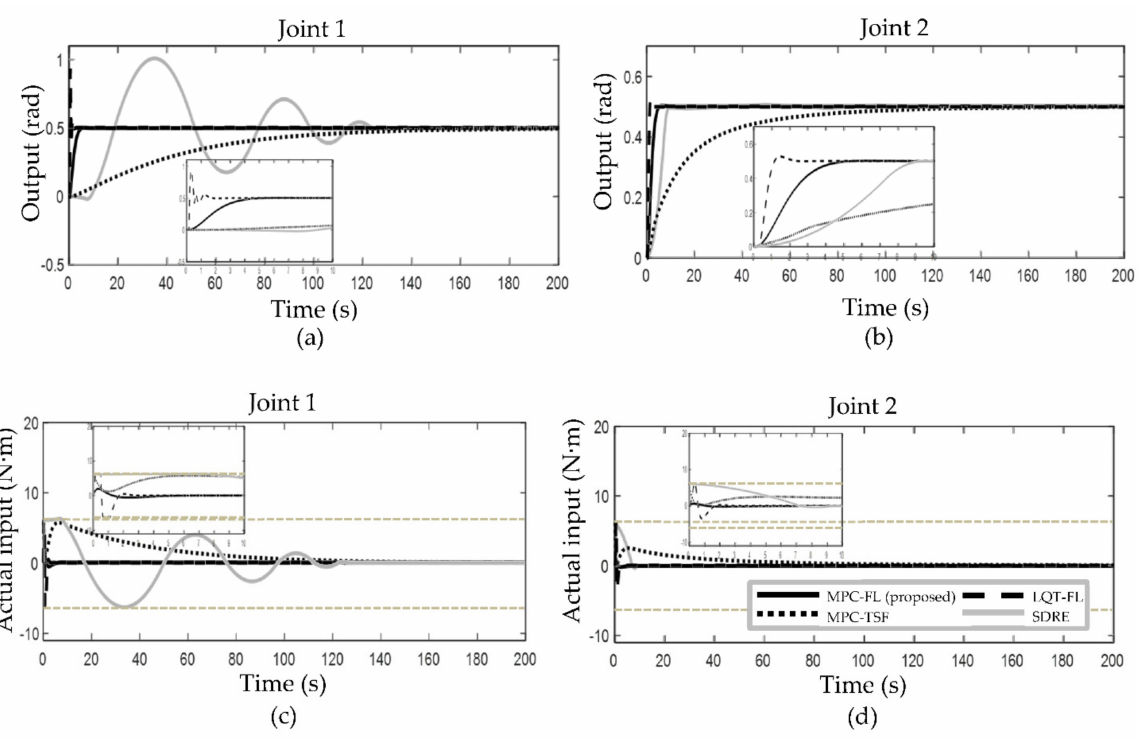
Figure 11. Two-link robot arm by applying the four control schemes with input constraints ± 6.1 N · m: ( a ) output responses of joint 1; ( b ) output responses of joint 2; ( c ) input signals of joint 1; ( d ) input signals of joint